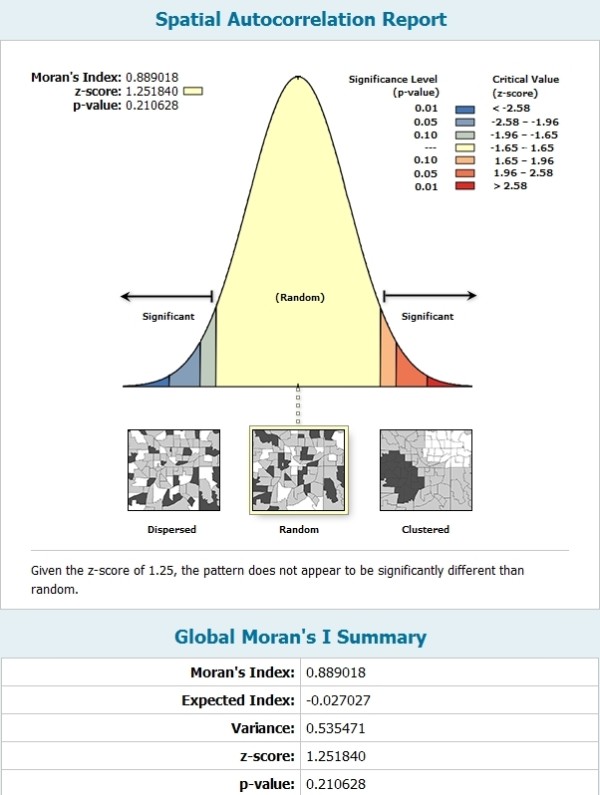
Spatial autocorrelation analysis results.